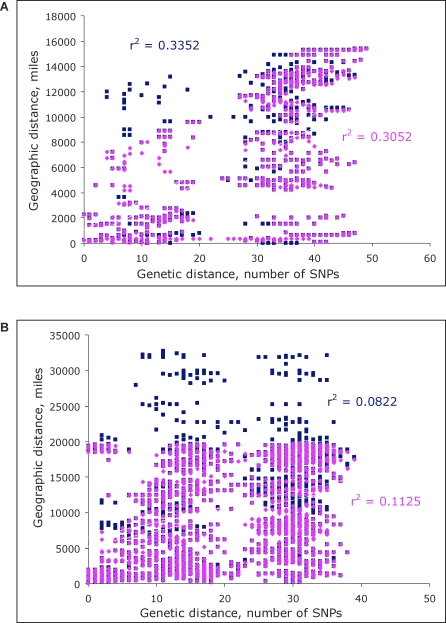
Correlations between Genetic and Geographic Distances in Ancient and Modern MTBC StrainsTo determine the route by which human-adapted MTBC strains were globally dispersed, we sought correlations between genetic and geographic distances in ancient (A) and modern (B) MTBC strains. The shortest distances between geographic locations via water routes (pink diamonds) or continental waypoints (i.e., land routes; blue squares) are plotted against the corresponding genetic distances expressed as the number of SNPs. In ancient strains, the correlation using either route was highly statistically significant (p < 0.0001 for both), but the correlation using land routes was slightly stronger. By contrast in modern strains the correlation using water routes was stronger and more statistically significant compared with land routes (p < 0.0001 and p = 0.05, respectively). Significant p values and r2 between 0 and 1 for all four analyses support the association between MTBC dispersal and human migration, which is consistent with early spread of MTBC out of Africa. The relative magnitude of r
2 for land routes versus water routes suggests that spread of ancient strains occurred over land (i.e., through ancient human migration) and modern strains over water (i.e., through recent historical migration, trade, and conquest).